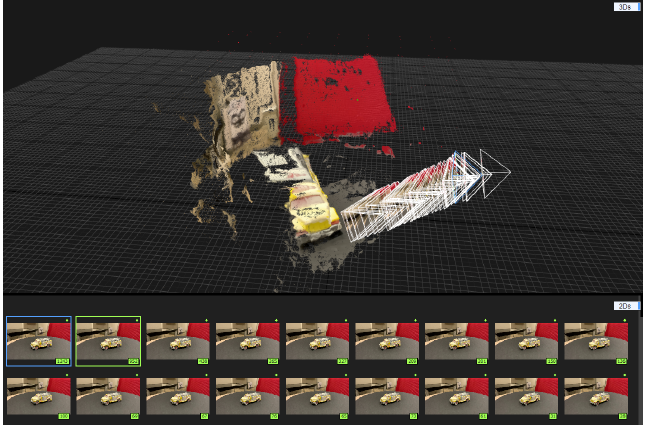
Figure 2. Example of uncontrolled environment